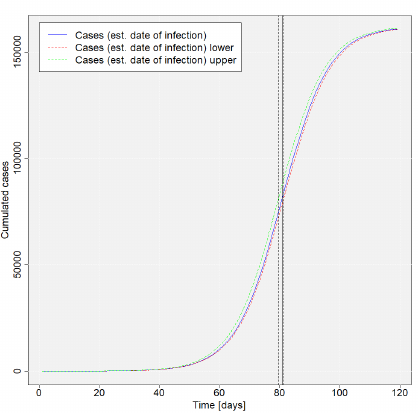
Figure 4: Estimated logistic growth model (including inflection point) for cumulative SARS-CoV-2 infections in Germany (based on estimated dates of infection) incorporating upper and lower bounds (95%-CI)